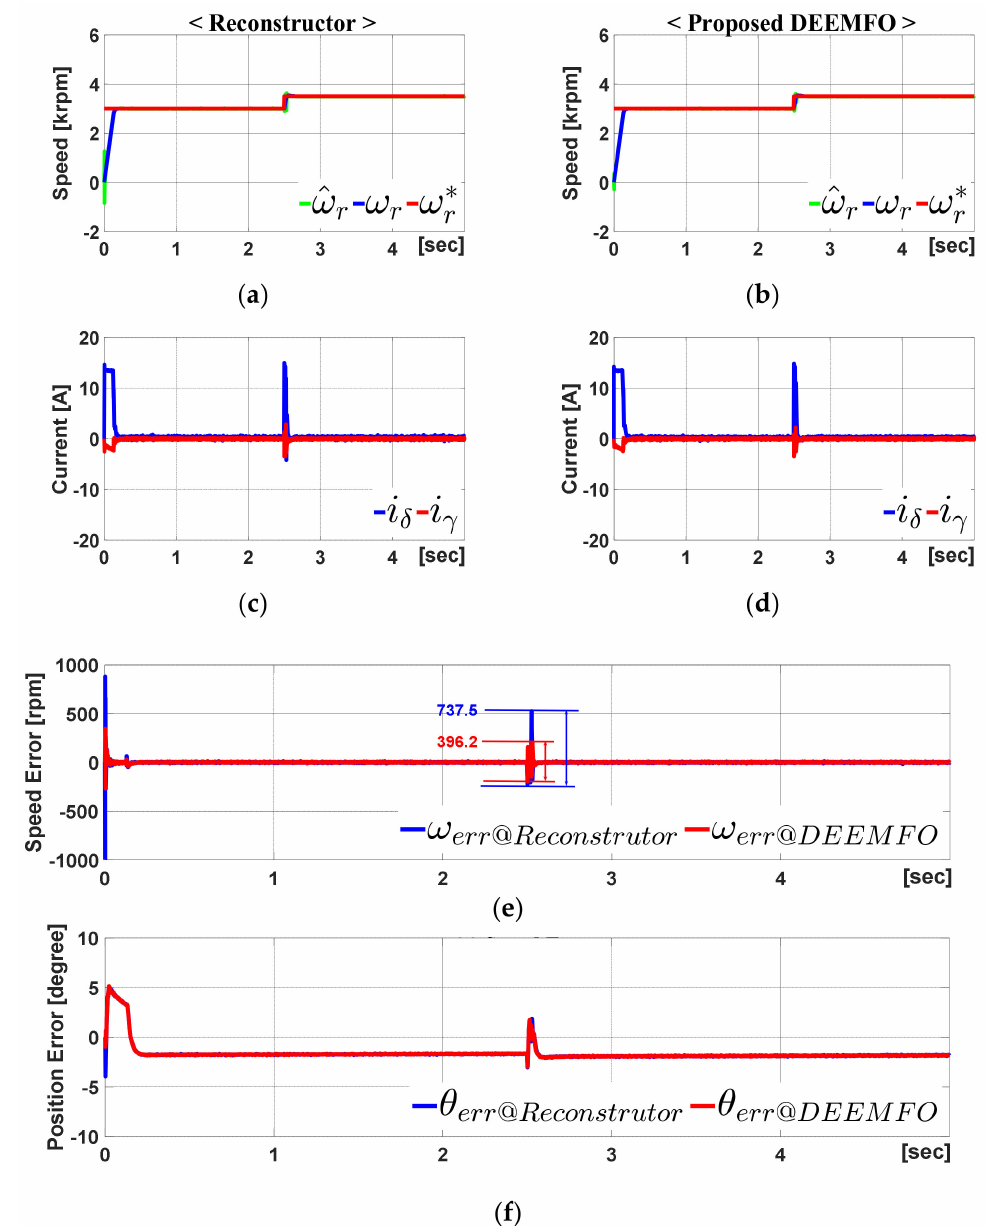
Figure 8. Simulation results under the condition that the speed reference increased from 3000 rpm to 3500 rpm. ( a ) reference, real, and estimated speed with reconstructor; ( b ) reference, real, and estimated speed with DEEMFO; ( c ) γ − δ axis currents with reconstructor; ( d ) γ − δ axis currents with DEEMFO; ( e ) comparison of speed errors in reconstructor and DEEMFO; ( f ) comparison of position errors in reconstructor and